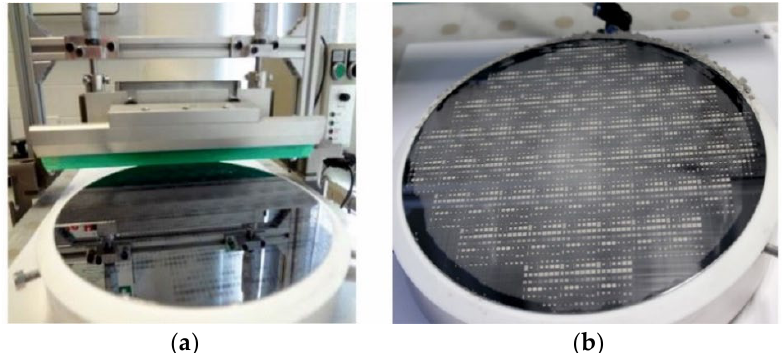
Figure 11. ( a ) Squeegee setup for removal of excess particles comprising a film applicator with a custom-built adapter for precise fixation of the vacuum chuck with the Si substrate. Please note, the micro molds of the substrate shown here are empty. The photograph in ( b ) presents a substrate processed using NdFeB powder after the final squeegee cycle with 5 µm gap.